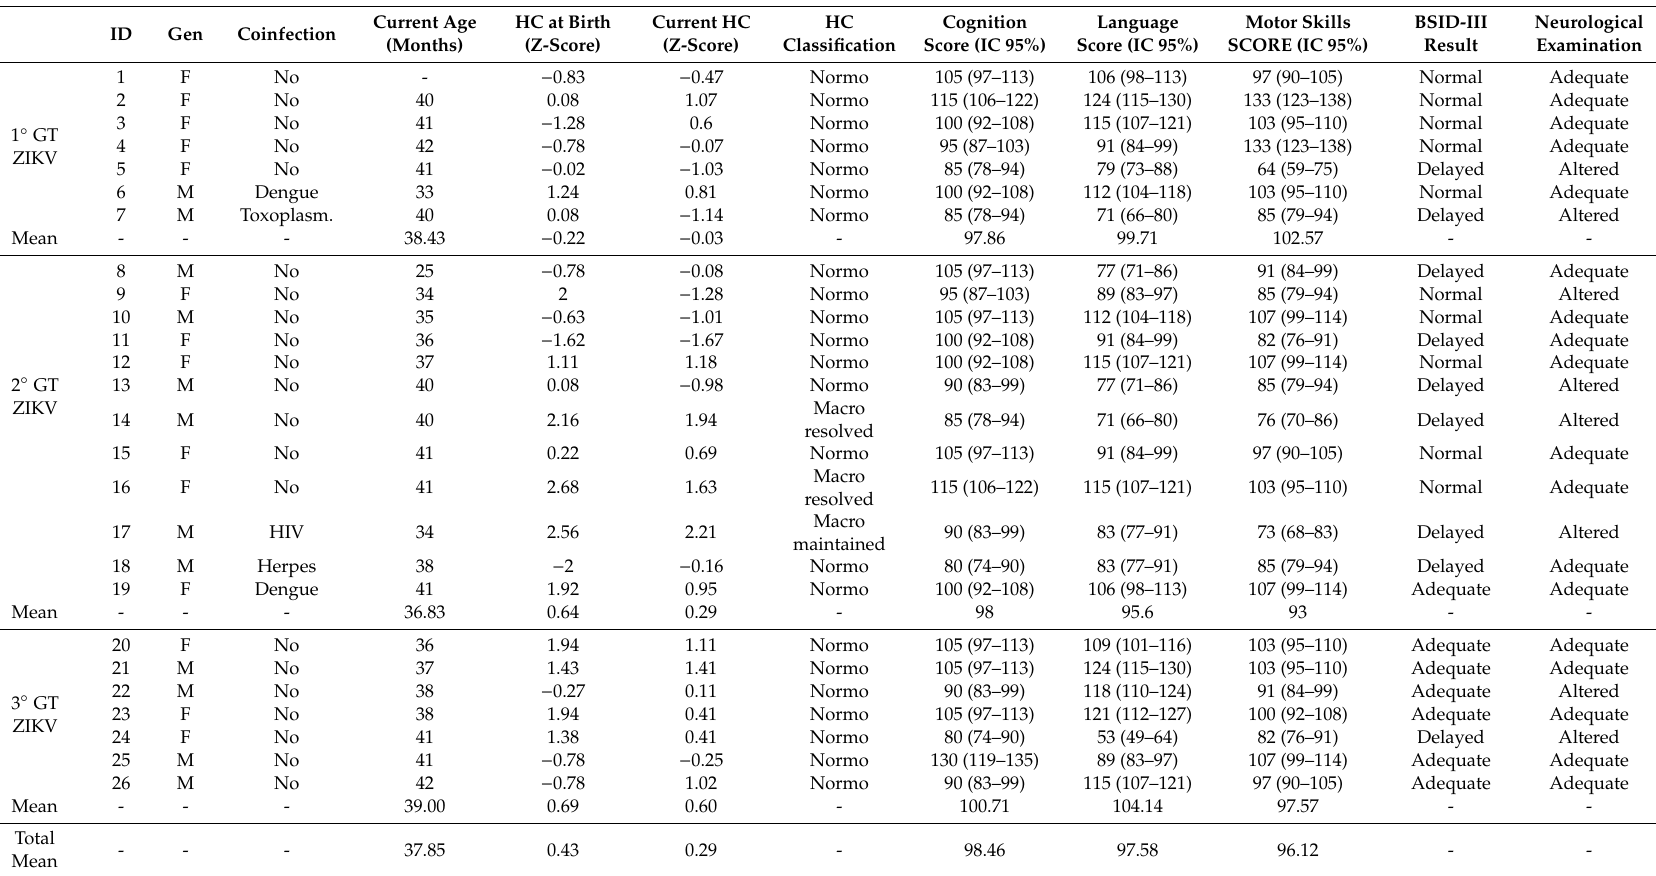
Table 2. Gestational trimester of occurrence of Zika virus (ZIKV) infection, gender, the presence of coinfections in pregnancy, age at the application of BSID-III, the head circumference at birth and the current evaluation (z-score), the results of the BSID-III evaluation and the neurological examination of 26 non-microcephalic children exposed to the Zika virus in the intrauterine period, Manaus, Amazonas,